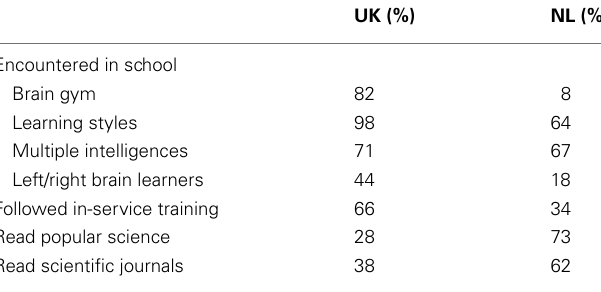
Table 2 |Teacher